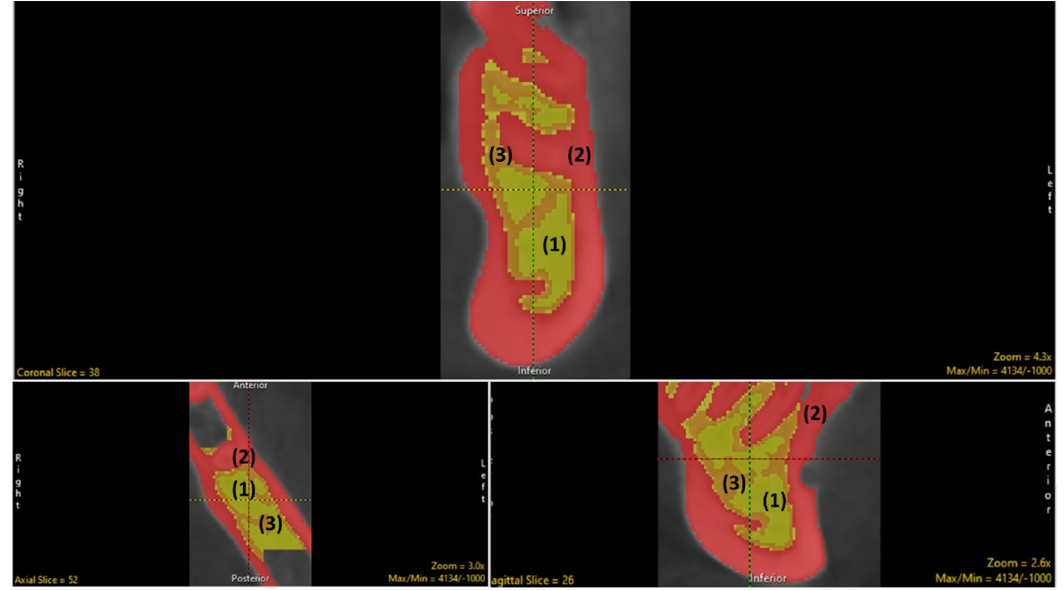
Figure 4. The trabecular component segmented into (1) inter-trabecular space, (2) cortical bone and (3) trabecular septae.